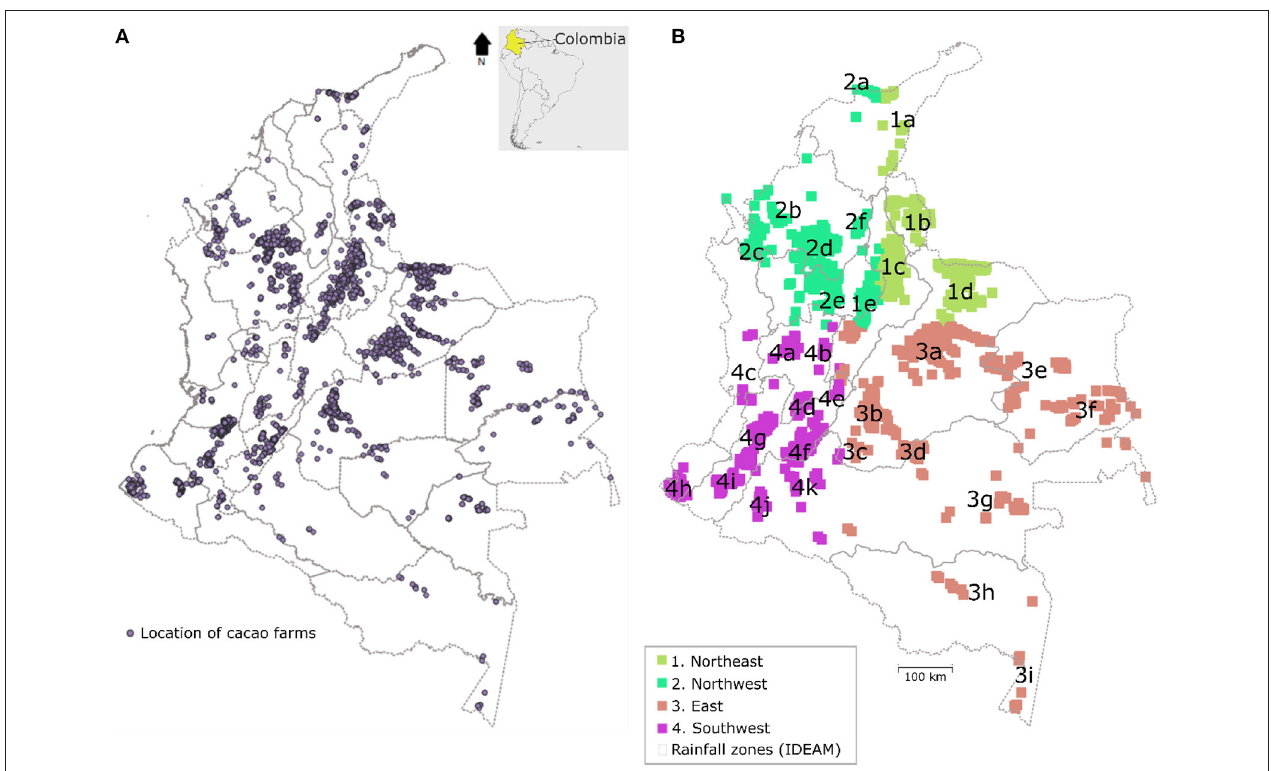
FIGURE 1 | Map of departments with geographical location of cacao farms across Colombia (A) . Color coded map of the proposed biogeographic regionalization of cultivated cacao ( Theobroma cacao L .) for Colombia (B) . The dotted lines background map in (B) shows the 2014 precipitation regions by the National Bureau of Meteorology